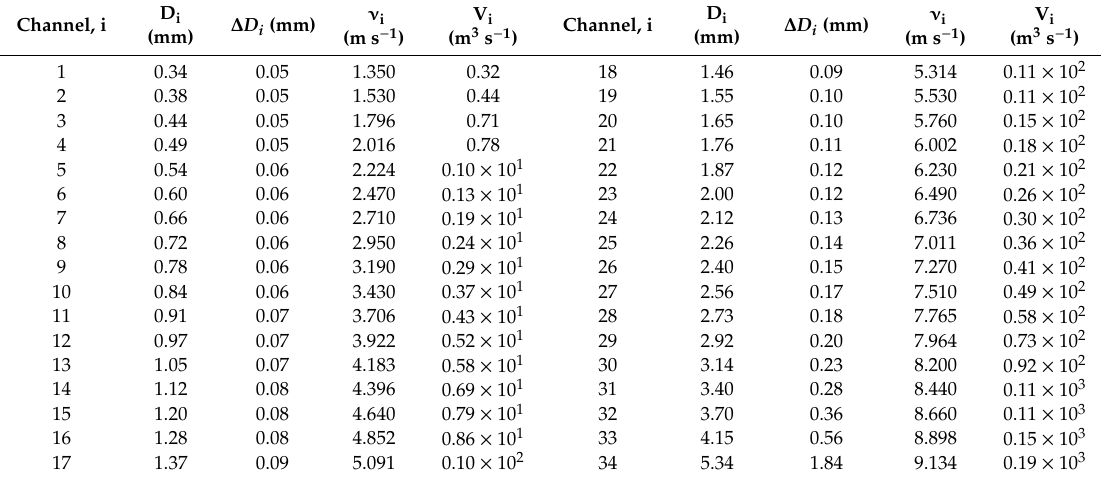
Table 2. Corresponding mean diameter D i (mm), diameter interval ∆ D i (mm), fall velocity ν i (m s − 1